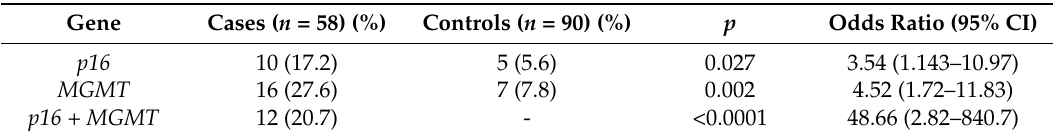
Table 2. Analysis of site-specific methylation on p16 and MGMT promoter regions in OSCC patients and